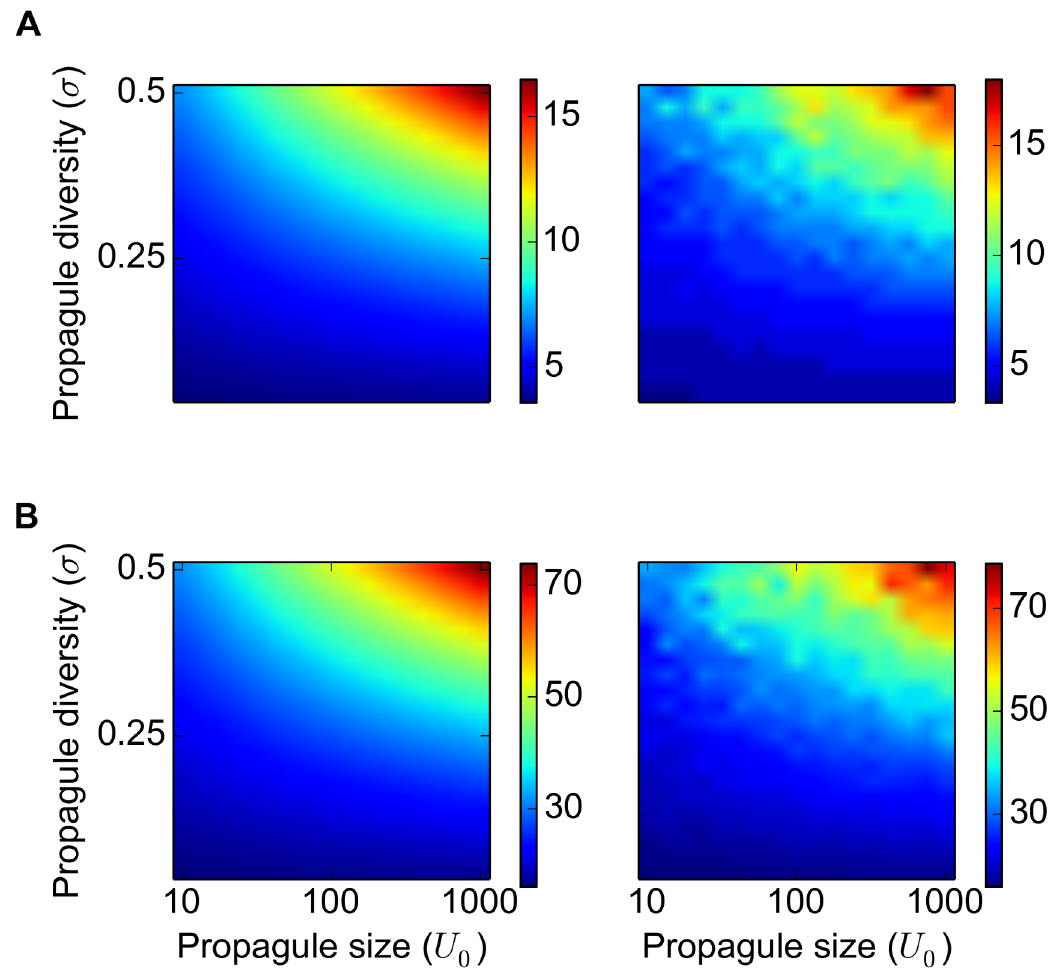
Figure 6. Propagule pressure and the median rate of spread. Theoretical (left) and computed (right) median of the asymptotic rate of spread for r ~ 0 : 75 , A: m ~ 1 and B: m ~ 2 : 5 . The computed median was obtained from 15 simulations for each set of parameter values.